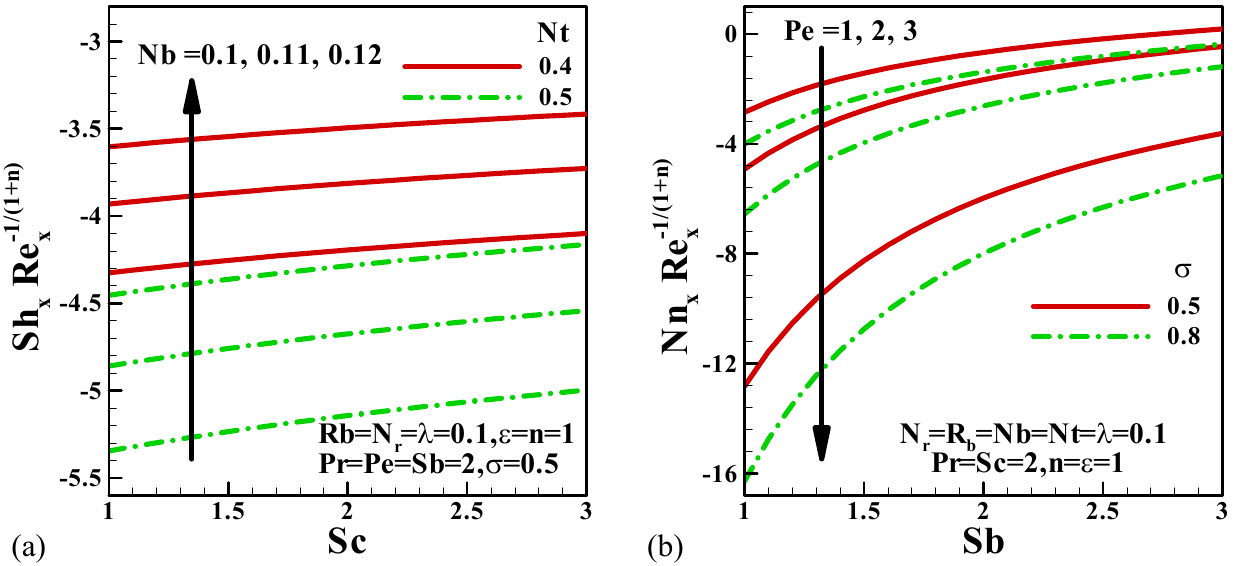
Figure 8. ( a ) Variation in the Sherwood number with the Schmidt number for different nanofluid parameters and ( b ) variation in the density number of the motile microorganisms. The mixed bioconvective flow of water-based nanofluid containing micro-organisms is investigated numerically using a Runge-Kutta–Fehlberg method of the seventh order (RKF7) coupled with a shooting method. The effects of bioconvection and nanofluid parameters on the dimensionless variables and quantities of interest are investigated numerically. The results are presented graphically and are compared with the existing